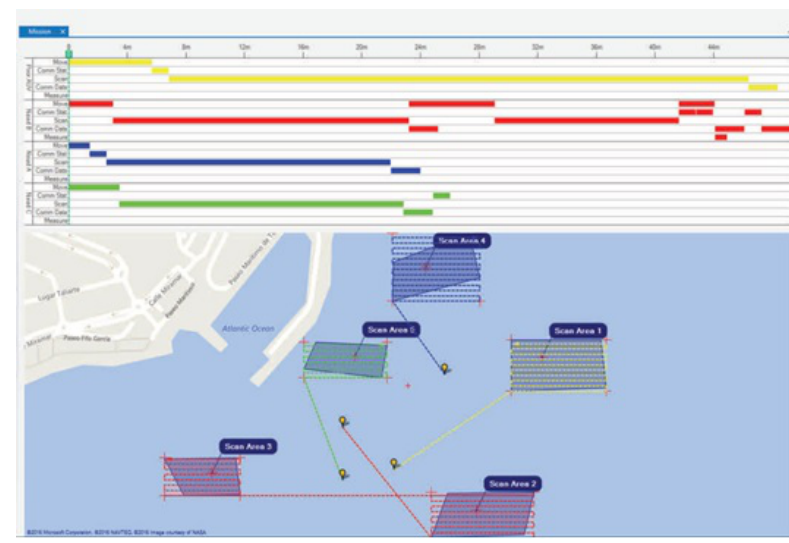
Figure 3. Results obtained with the GUI